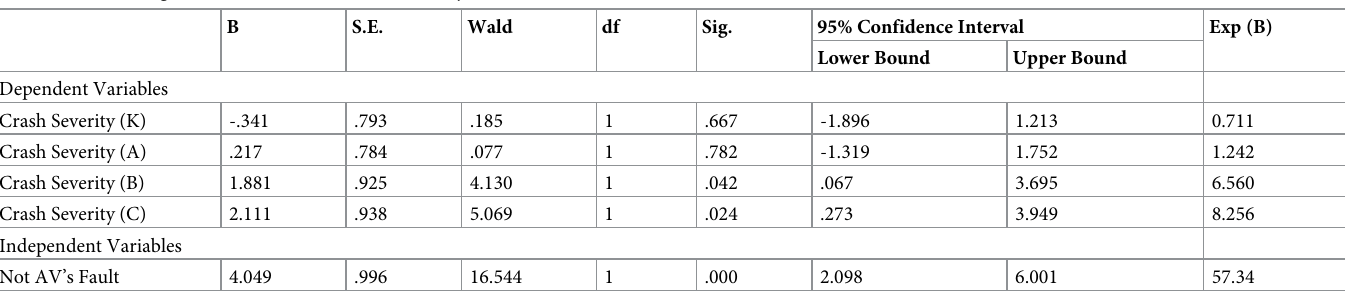
Table 2. Ordinal logistic model results for crash severity (AD mode).